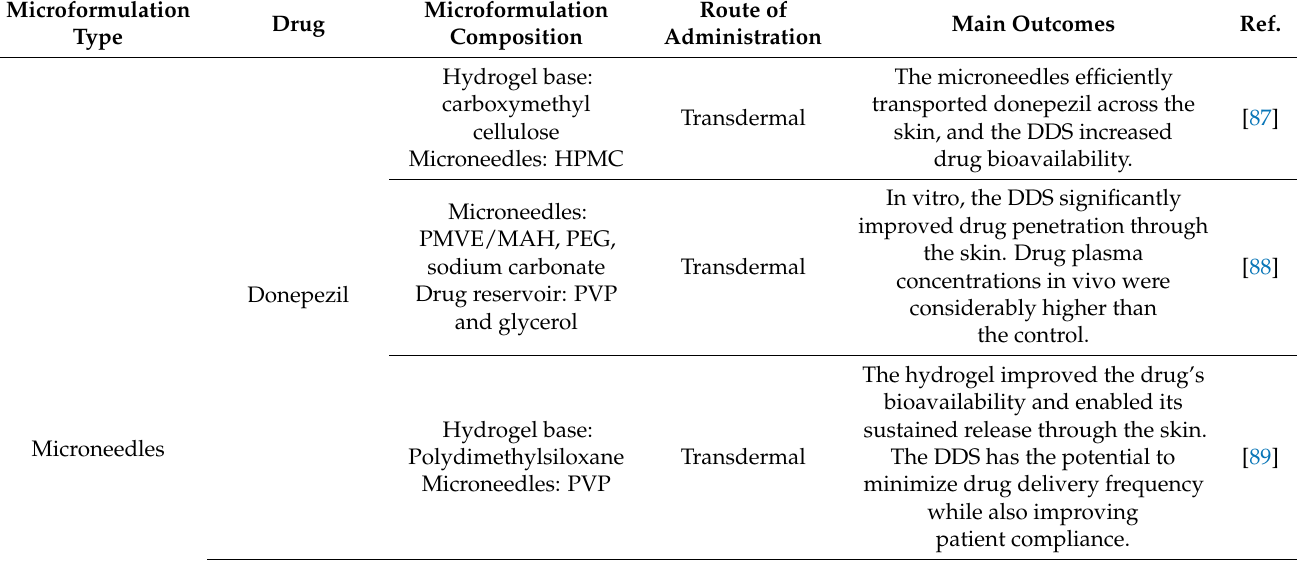
Table 3. The most recent applications of microformulations as DDSs for delivering FDA-approved Alzheimer’s